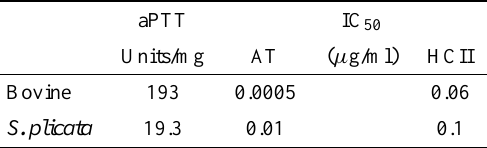
ValuesofplasmaaPTTandIC 50 forthrombinin- hibitionbyATandHCIIinthepresenceofbovine or S. plicata